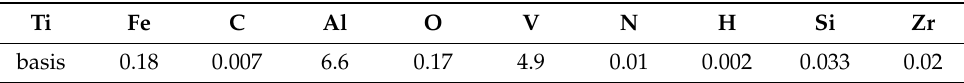
Table 1. Chemical composition of Ti-6Al-4V alloy (in wt.%). Ti Fe C Al O V N H Si Zr basis 0.18 0.007 6.6 0.17 4.9 0.01 0.002 0.033